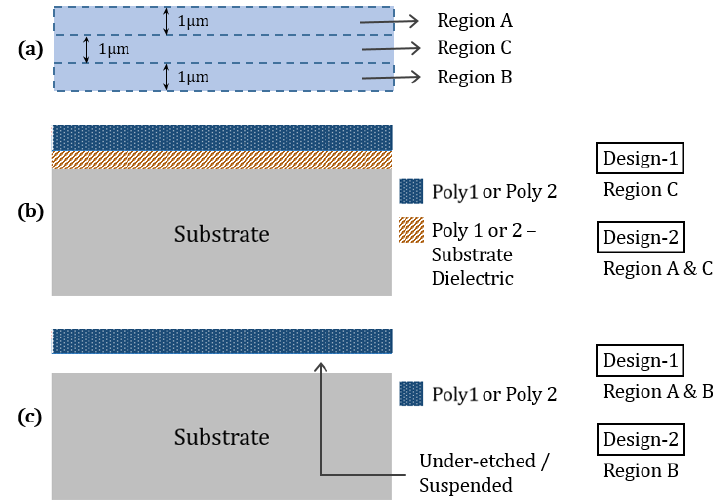
Figure 3. Partially suspended polysilicon microheater design illustrations. ( a ) Microheater surface area; ( b ) cross-sectional view of non-suspended region, and ( c ) cross-sectional view of suspended region.